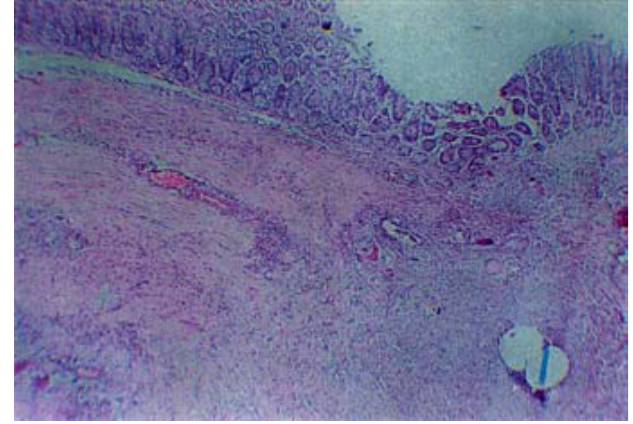
FIGURE 3 – Photomicrography of coaptation of the mucosa and